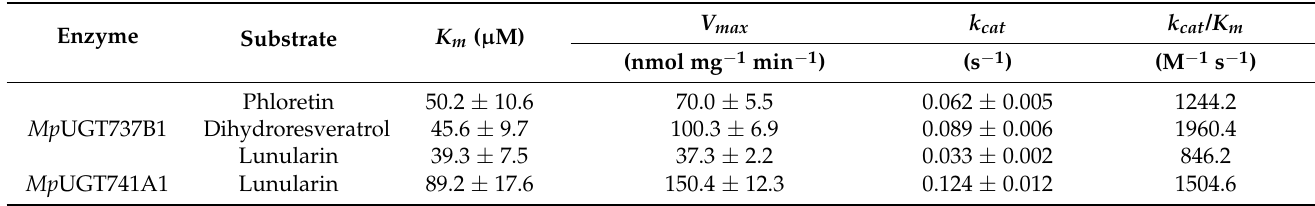
Table 2. Kinetic parameters of the recombinant Mp UGT737B1 and Mp